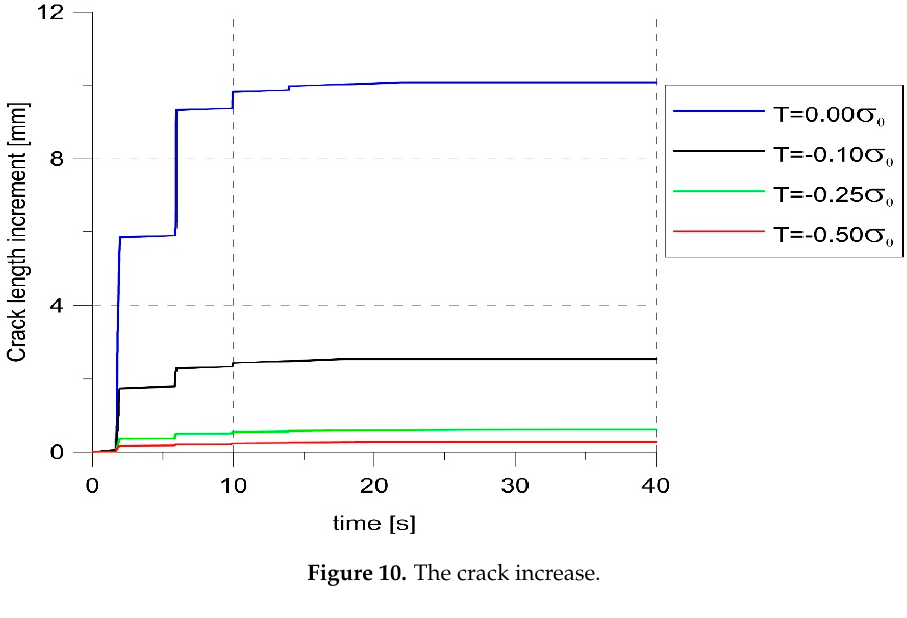
Figure 10 . The crack increase. Figure 10. The crack increase. Materials 2020 , 13 , x FOR PEER REVIEW